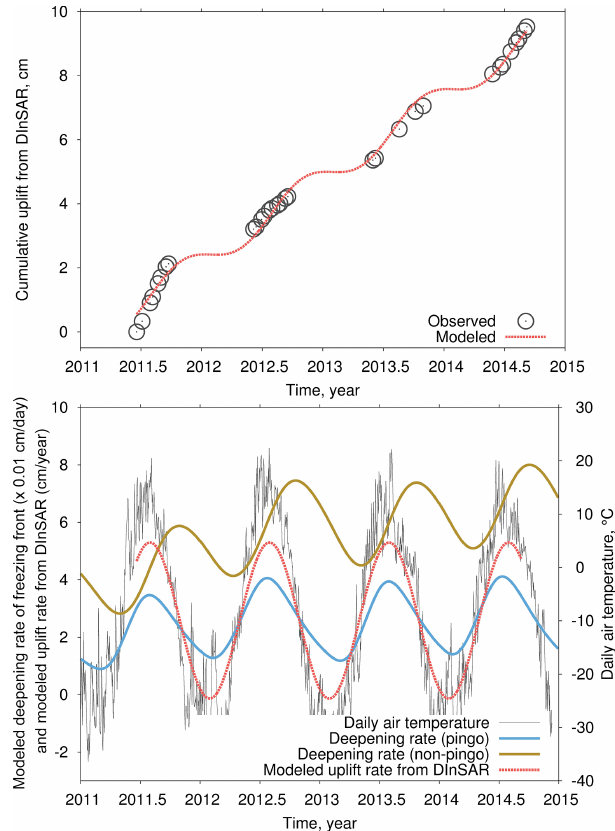
Figure 9. (Top) Observed and modeled (according to Eq. 2) up- lift time series for area experiencing maximum uplift and (bot- tom) modeled deepening rate of freezing front for pingo (blue line) and non-pingo (brown line) scenarios assuming drainage of resid- ual pond in 1940, modeled (according to Eq. 2) uplift rate (red dashed line), and mean daily air temperature observed at Tuktoy- aktuk weather station located 10km northeast from the study site (gray line). Acceleration of uplift is observed in July when deep- ening rate of freezing front is greatest and air temperature reaches annual